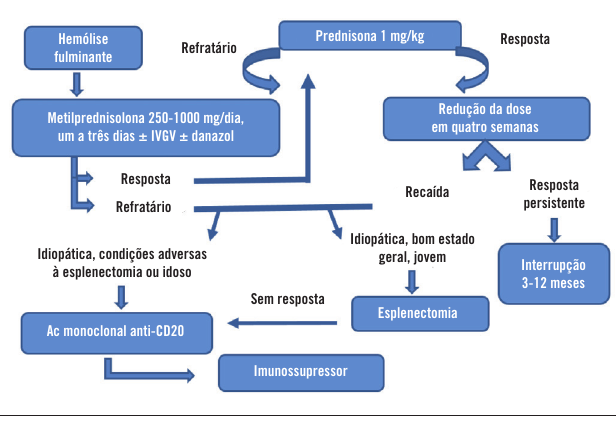
Figura 1 − Fluxograma do tratamento da AHAI a quente AHAI: anemia hemolítica autoimune; IVGV: imunoglobulinas por via intravenosa; Ac: